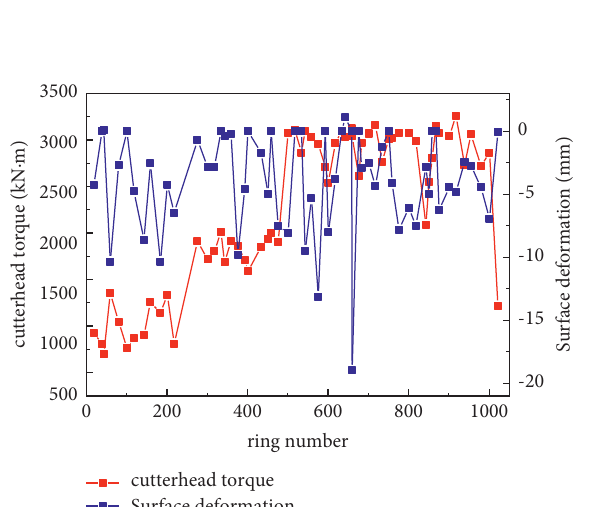
Figure 12: Relationship between displacement and torque of the former line.